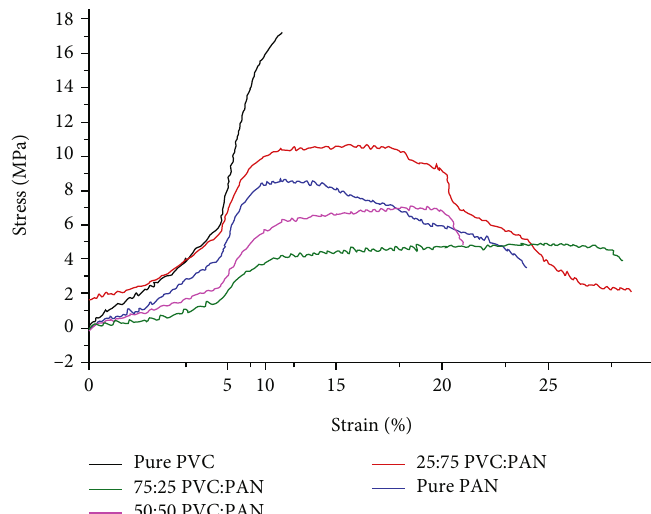
Figure 7: Stress-strain relation for the nonwoven blend mats of PVC: PAN with many blending ratios.